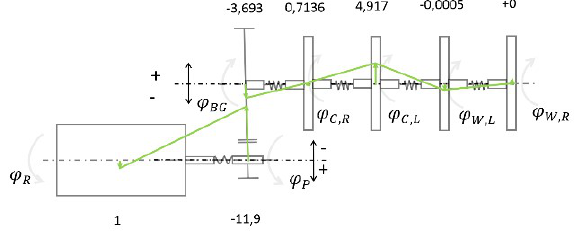
Figure 14. Fifth natural mode of torsion oscilla- tions [3].